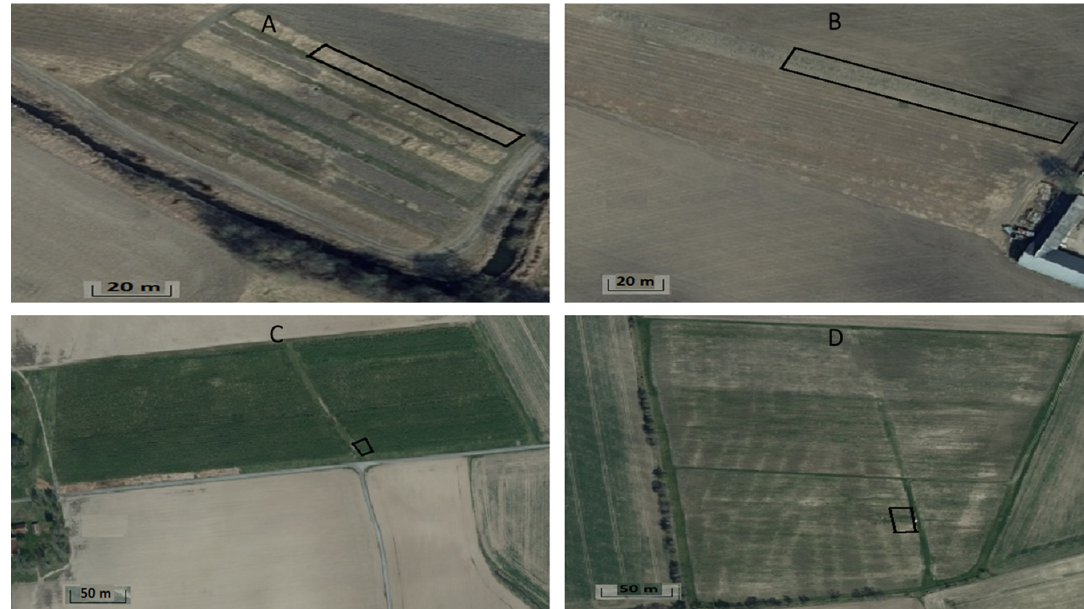
Figure 1. The different plantations where the measurements were done. ( A ) Plot 1, the field trial of second year growing varieties established in 2014. ( B ) Plot 2, the field trial of first year growing varieties established in 2017. ( C ) Plot 3, the biofuel plantation of first year growing trees established in 2017. ( D ) Plot 4, the biofuel plantation of first year growing trees established in 2003. The black rectangles indicate the positions of the leaf scale measurement. The photos are modified from Lantmäteriet